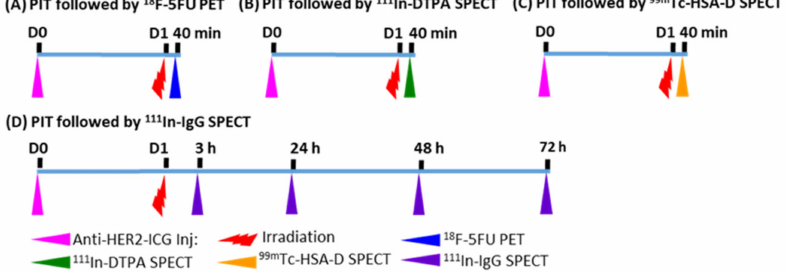
Figure 1. Experimental treatment scheme. ( A ) 18 F-5FU PET imaging at 40 min after NIR-PIT; ( B ) 111 In-DTPA SPECT imaging at 40 min after NIR-PIT; ( C ) 99m Tc-HSA-D SPECT imaging at 40 min after NIR-PIT; ( D ) 111 In-IgG SPECT imaging at 3, 24, 48, and 72 h after NIR-PIT. Intravenous injection of anti-HER2-ICG into mice was performed one day before